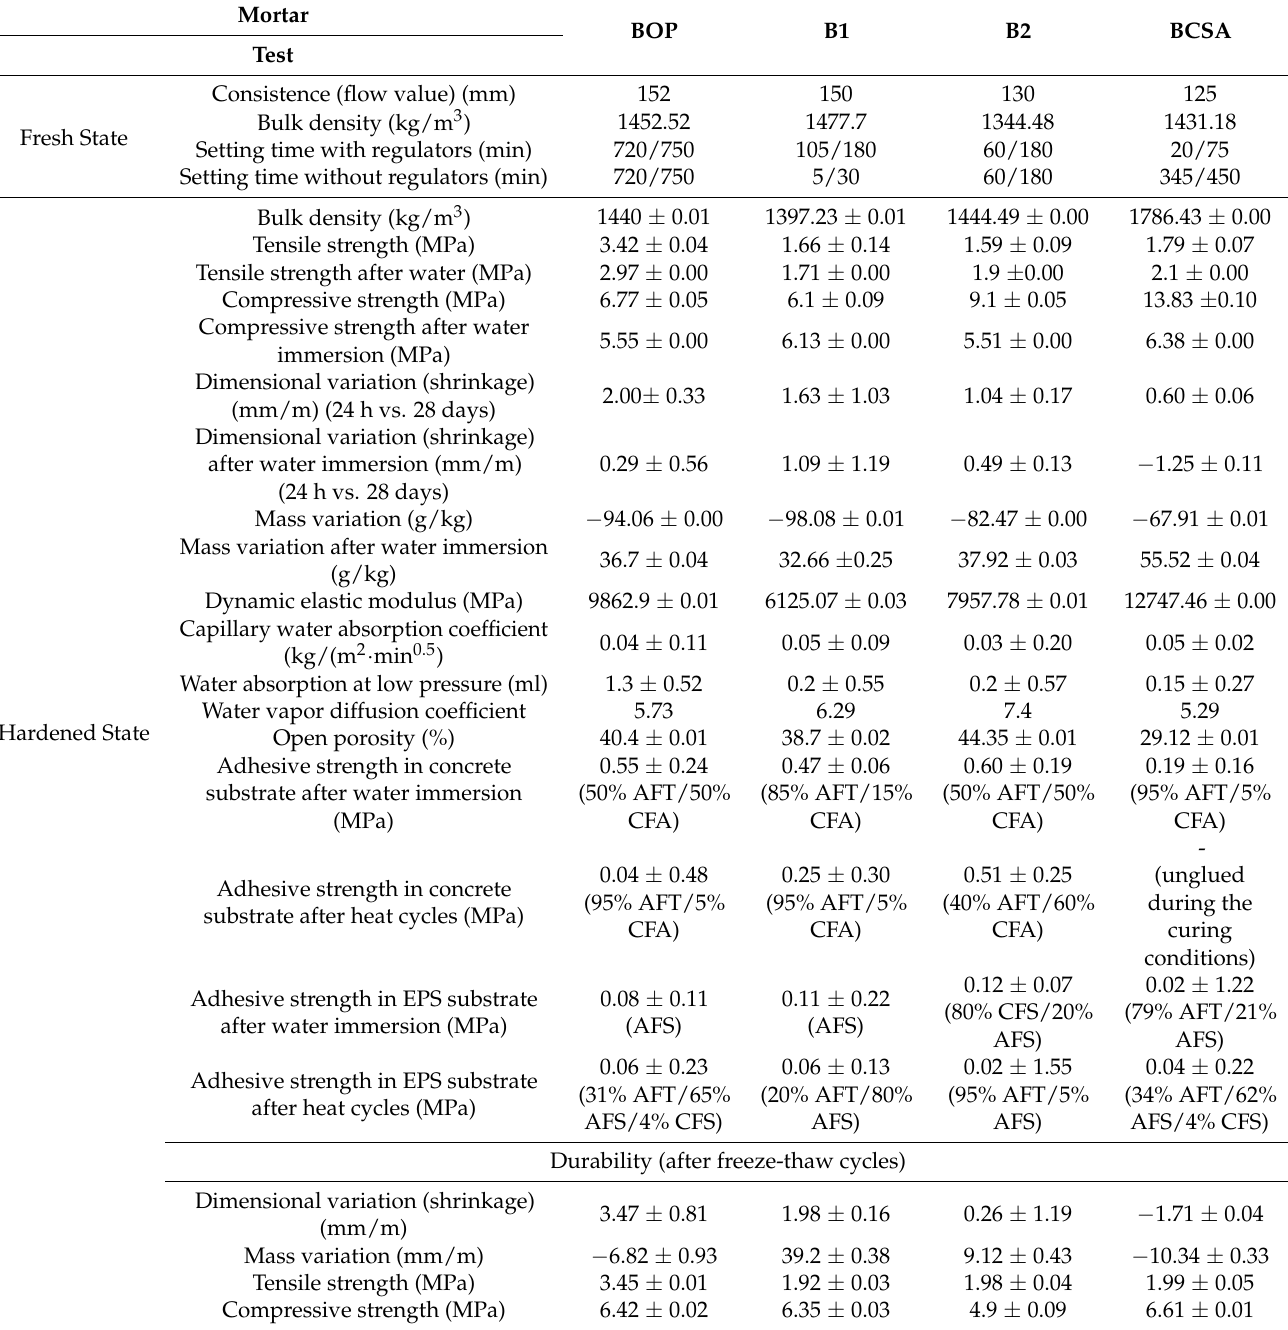
Table 7. Physical-mechanical and durability results of the basecoat